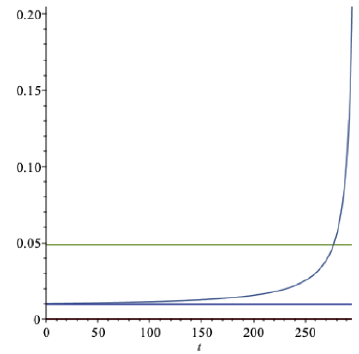
Figure 6. Optimal spending rate vs. expected return; γ < ρ